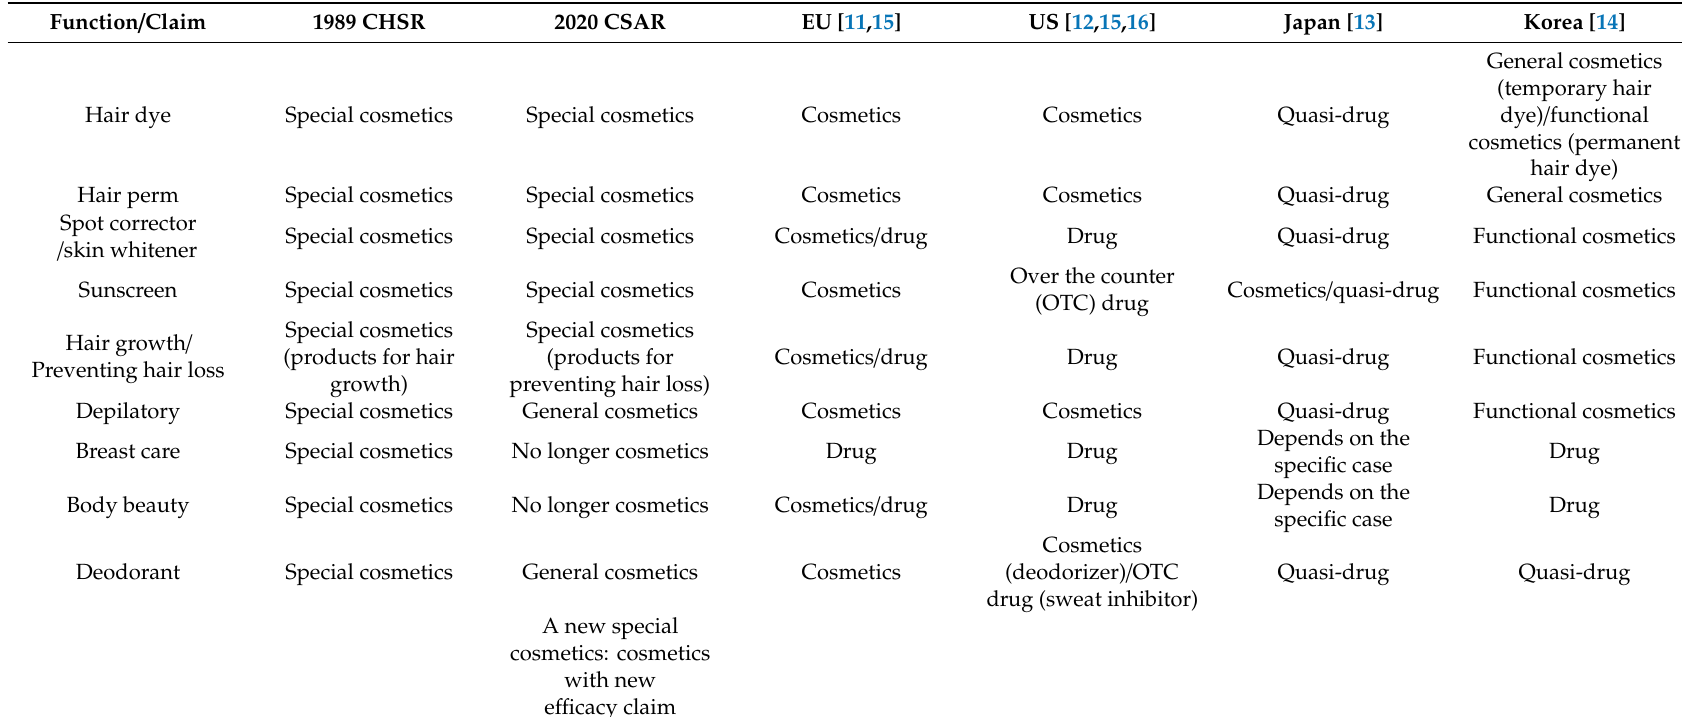
Table 3. A general comparison of product